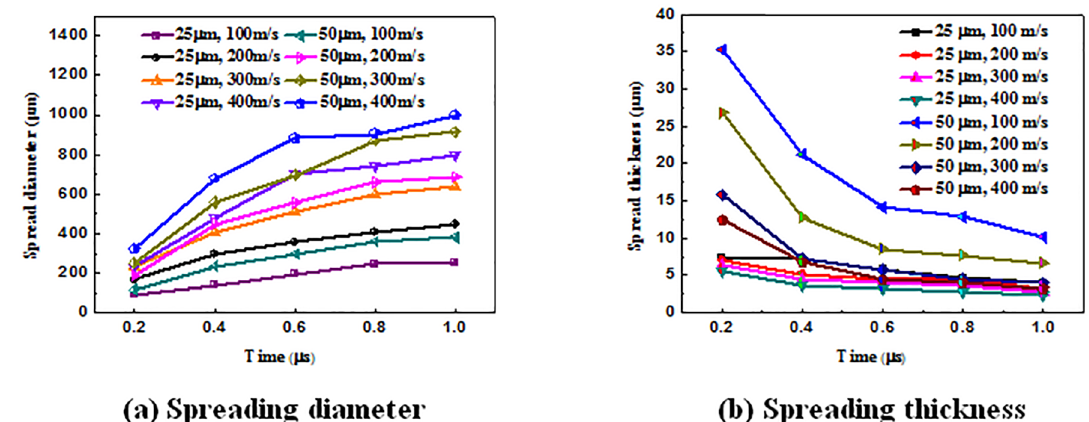
Figure 5. Relationships between droplet spreading diameter and thickness and solidification time for (a) and